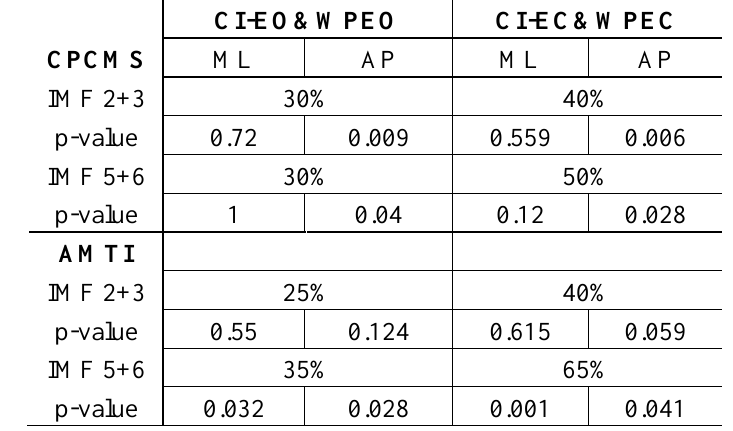
Table 6. Compare EMD-Enhanced MSE use IMF 2+3 and IMF 5+6 (CI-EO&WPEO is to compare complexity index for eyes open and water pad with eyes open, CI-EC&WPEC is to compare complexity index for eyes closed and water pad with eyes closed).